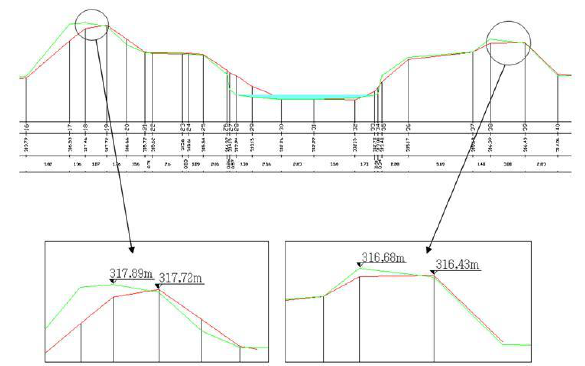
Figure 18. Determination of elevation of embankment summit - Topographic survey in green, interpolated surface from DTM in red